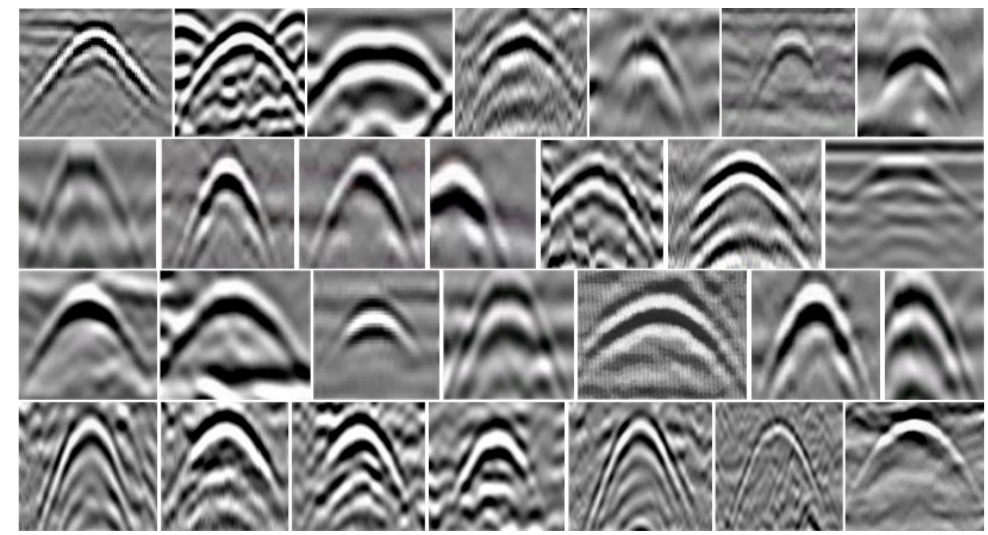
Figure 1. Parabolic target feature marker.